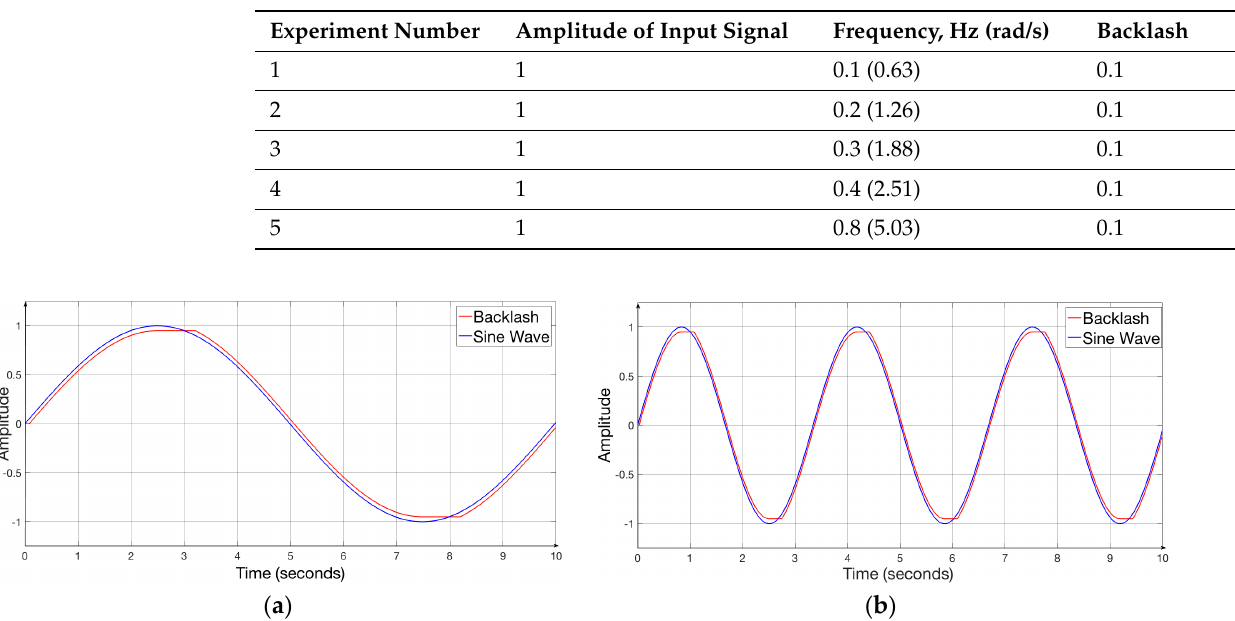
Figure 19. S imulation of cases 1 ( a ) and 3 ( b ). Amplitude is constant. Figure A1. Simulation of cases 1 ( a ) and 3 ( b ). Amplitude is